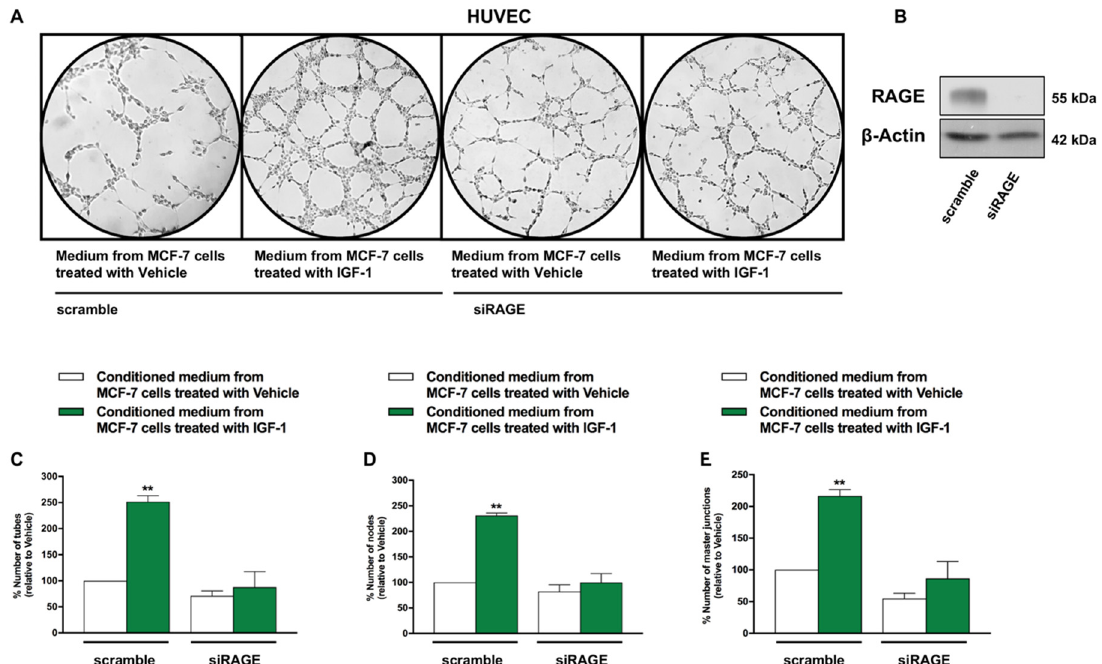
Figure 7. IGF-1 triggers the formation of endothelial tubes by activating the S100A7/RAGE signaling. ( A ) HUVECs were transfected with siRAGE (10 nM) or non-targeting scramble siRNA for 24 h. Thereafter, tube formation assay was per- formed on HUVECs, which were detached and cultured in medium collected from MCF-7 cells treated with either vehicle or IGF-1 (10 nM, 48 h). Tube formation was evaluated 8 h after HUVEC seeding. ( B ) Efficacy of RAGE silencing in HU- VECs. ( C – E ) Quantification of the number of tubes, number of nodes and number of master junctions observed in HU- VECs, as indicated. Data shown are the mean ± SEM of at least two independent experiments performed in duplicate. (**) p < 0.01.